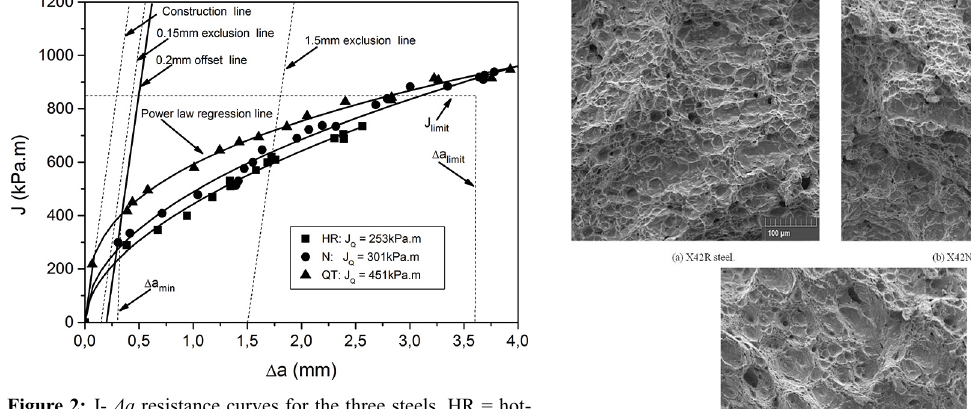
Figure 2: J- Δa resistance curves for the three steels. HR = hot- rolled; N = normalized; QT = quenched and tempered. The value is showed for the steels. of J Q